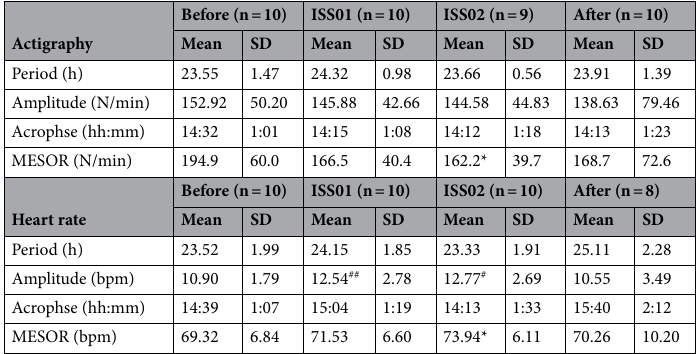
Table 1. Circadian period of the sleep–wake cycle, heart rate, and intrinsic cardiovascular regulatory system. * P < 0.05 vs. Before. # P < 0.05 vs. After, ## P < 0.01 vs. After. P -values not corrected for multiple